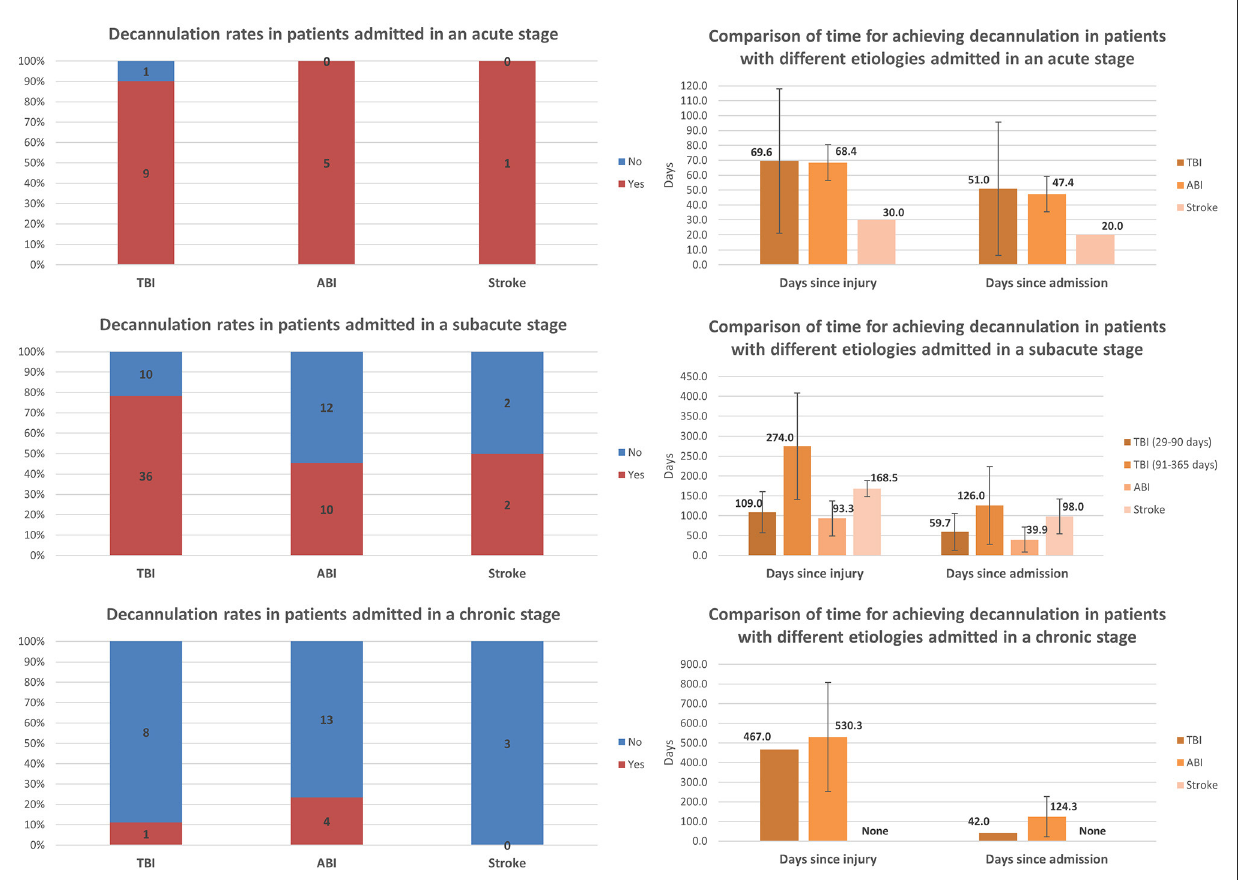
FIGURE3 Comparison of decannulation rates and time to achieve decannulation among patients with different etiologies and admitted at different stages post-injury (error bars represent standard deviations).